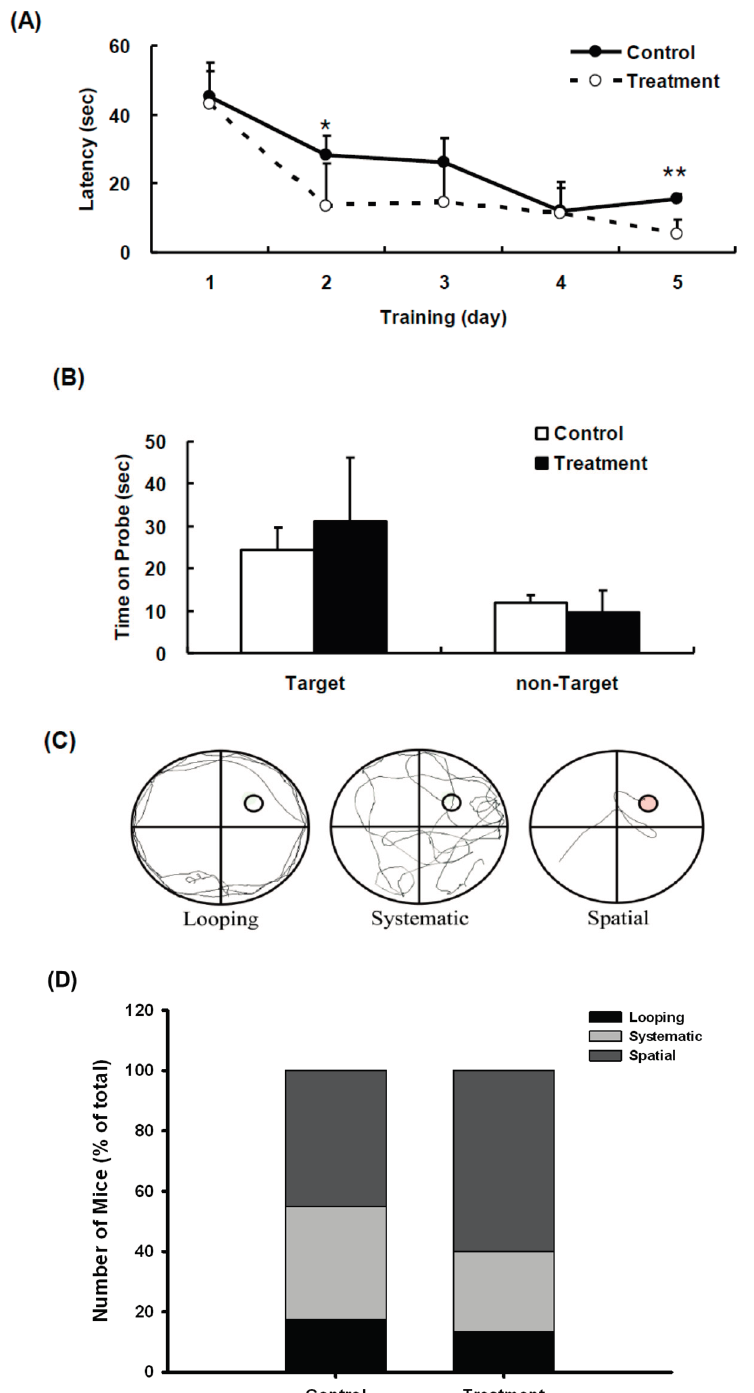
Figure 7. Effects of NB34 on Spatial memory performance in the Morris water maze (MWM). ( A ) Acquisition trials. The time spent to reach the platform (escape latency). * p < 0.05 when compared with the corresponding control groups; ** p < 0.005 when compared with the corresponding control groups; ( B ) Probe trial. Probe test performed 24 h after the hidden platform acquisition period. Time spent in the target quadrant was similar in two groups; ( C ) Examples of search strategies; ( D ) Comparison of swimming strategies during acquisition phase of MWM between control and NB34 treated ApoE − / − mice combine with HFD. Search strategy was examined for first of the 4 trials on different acquisition